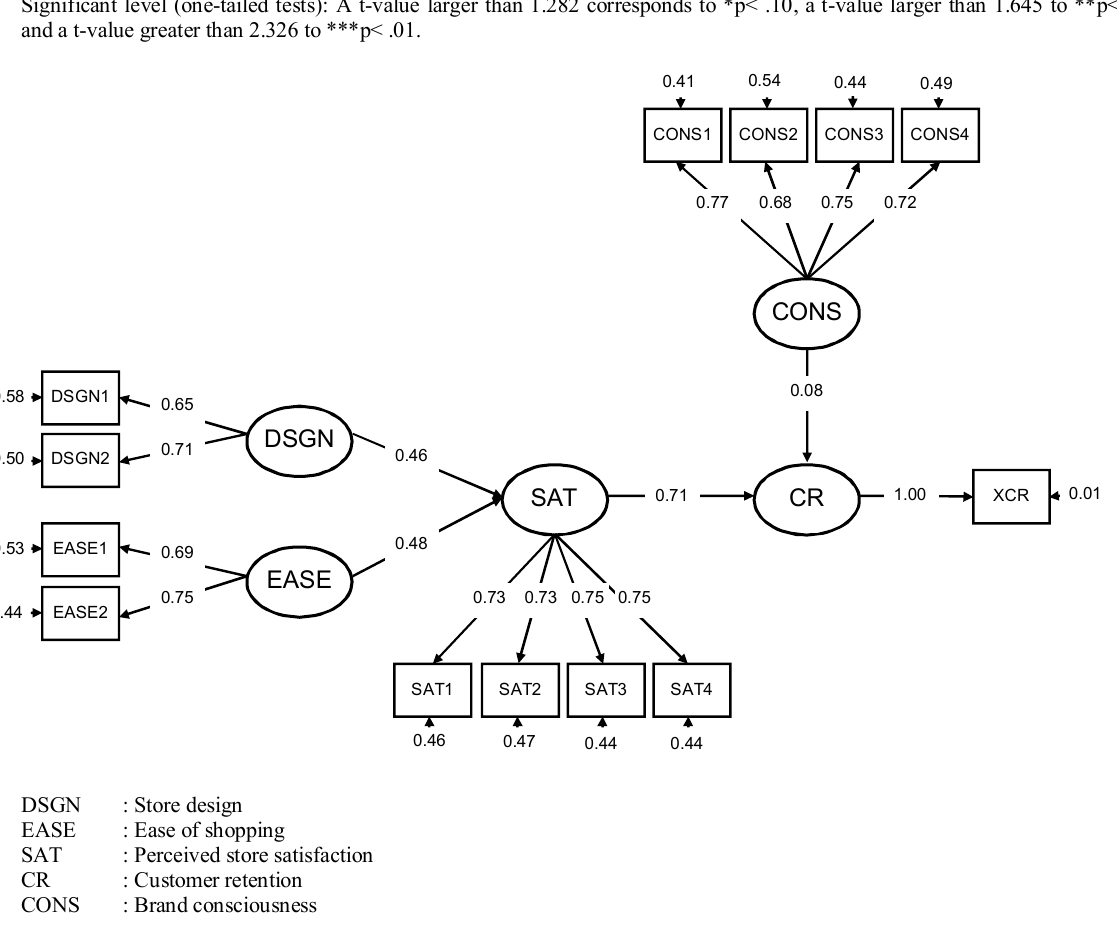
Figure 3. Proposed Research Model Results for Brand M 25% of the customer retention, whereas the model with perceived store satisfaction explains 43%. For Brand M, the model with two aspects of store-related explains only 41% of the customer retention, whereas the model with perceived store satisfaction explains 57%. Similarly, when brand consciousness is excluded from the fully mediated model, the variance explained in customer retention drops to 35% from 41% in the case of Brand F responded by female sample, but any change does not take place in the case of Brand M responded by male sample. Based on these results, the parameter estimates coming from the fully mediated model are reported and